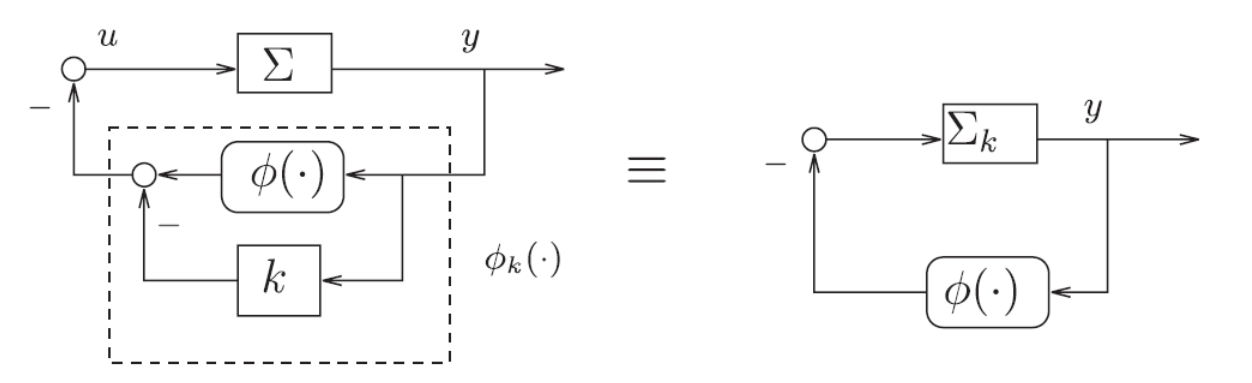
Figure 2. Equivalent representations of the Lure SISO nonlinear system